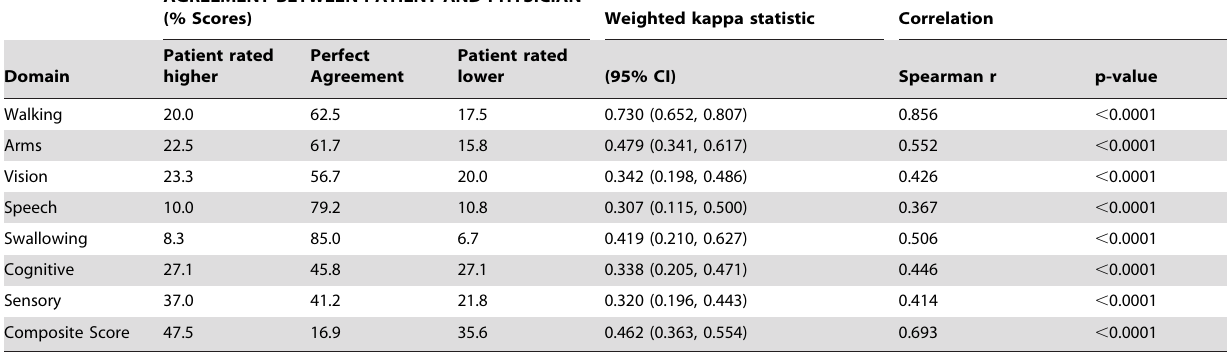
AGREEMENT BETWEEN PATIENT AND PHYSICIAN (% Scores)